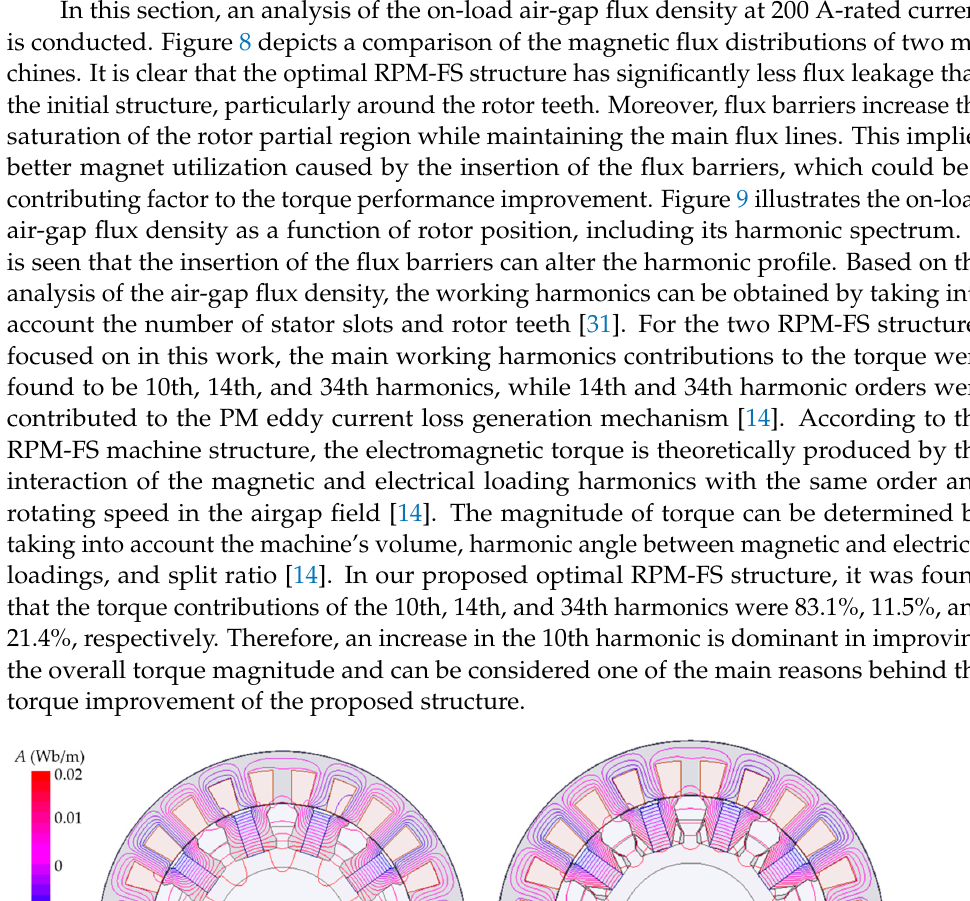
Figure 7. Comparison of cogging torque.